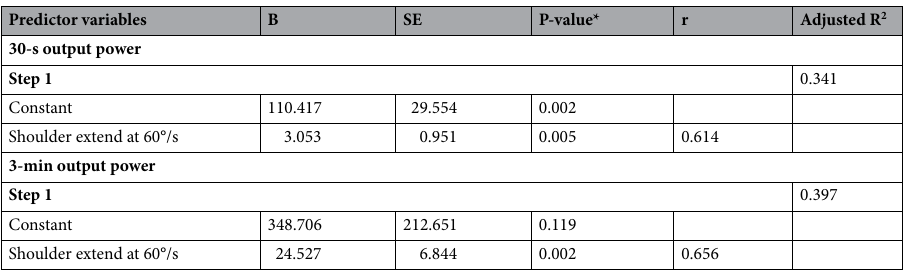
Table 3. Unstandardized coefficient, standard error, partial correlation, and adjusted R 2 of stepwise multiple regression analysis on the upper limb extended muscle strength and output power of 30-s and 3-min. B unstandardized coefficient, SE standard error, r partial correlation. *All regression models were statistically significant ( P < 0.05).